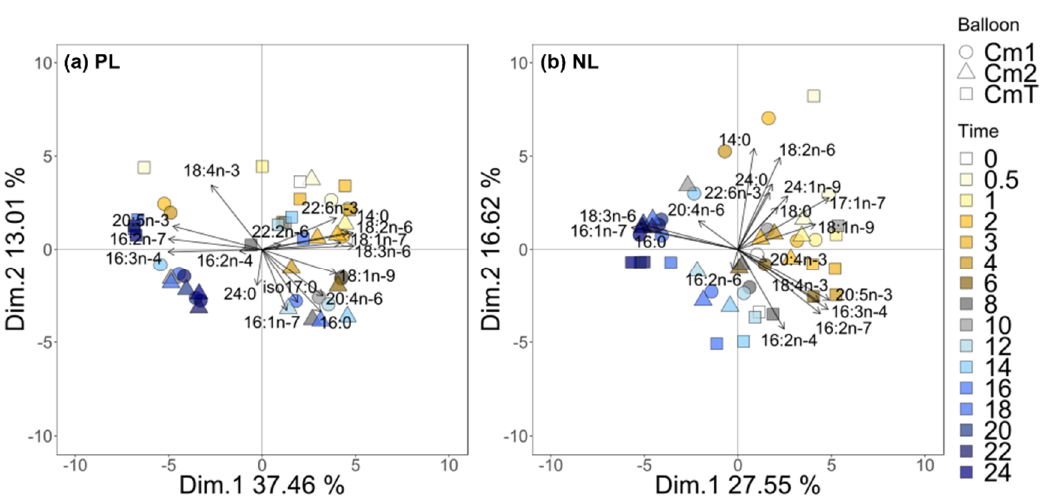
Figure 7. Principal component analyses (PCA) made with %mass for all the fatty acids in the polar fraction (PL) ( a ) and the neutral fraction (NL) ( b ). Only the FA selected by SIMPER analysis are shown here (explaining 80% of the variability). The colors represent the different sampling times from t 0 to t 24 , and the symbols represent the balloons considered. Cm1 and Cm2 are the enriched balloons, CmT the control balloon (Cm = Chaetoceros muelleri , n = 48 for NL and n = 48 for PL). Concentration (µmolC·L −1 ) dynamics of 16:3n-4, 20:5n-3, 16:0 and 16:1n-7 are shown in Figure 8.